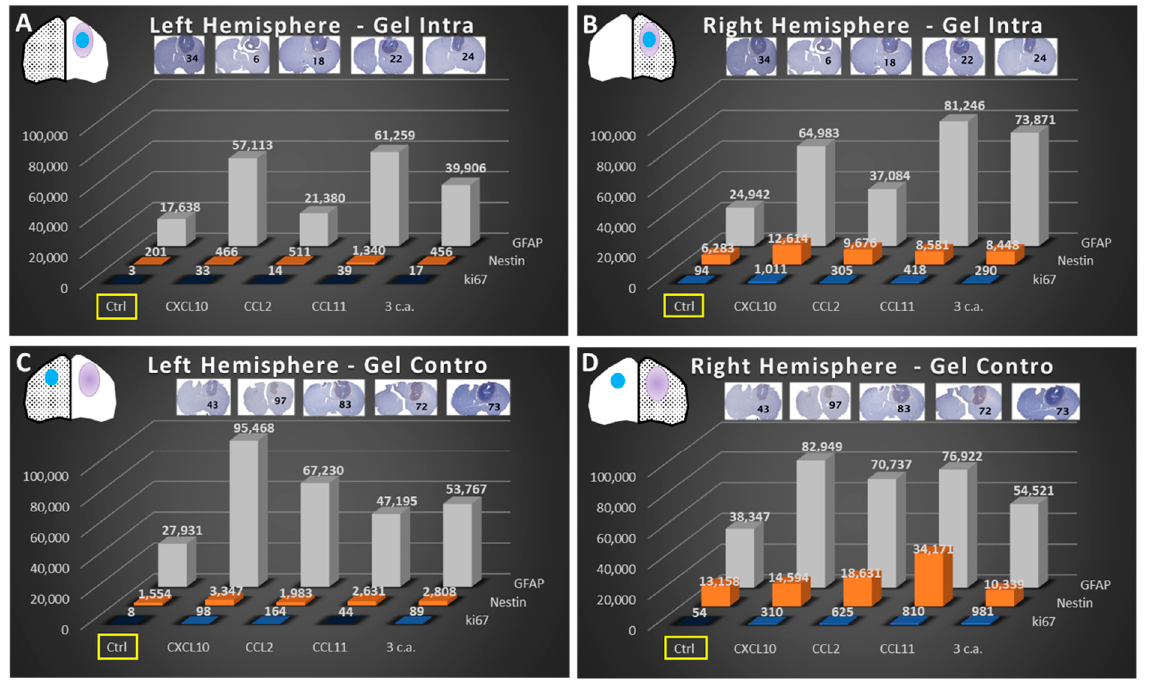
Figure 5. Quantification of the staining score of brain immunohistology of F98 glioma bearing rats for the hemisphere having received GlioGel with or without chemoattractant. ( A ) Fraction staining score for each marker and all chemokines of the ipsilateral hemisphere when the GlioGel is implant in the tumor. ( B ) Fraction staining score for each marker and all chemokines of the intratumoral hemisphere when the GlioGel is implant in the tumor. ( C ) Fraction staining score for each marker and all chemokines of the ipsilateral hemisphere when the GlioGel is implant in the ipsilateral hemisphere (without tumor). ( D ) Fraction staining score for each marker and all chemokines of the intratumoral hemisphere when the GlioGel is implant in the ipsilateral hemisphere (without tumor). Fraction staining score values for GFAP, nestin and Ki-67 appear in gray, orange and blue, respectively. Ctrl = Control. Black numbers in the right hemispheres represent the amount of satellite clusters. Blue circles represent the GlioGel and the texture in each hemisphere is for indicate which hemisphere is selected.